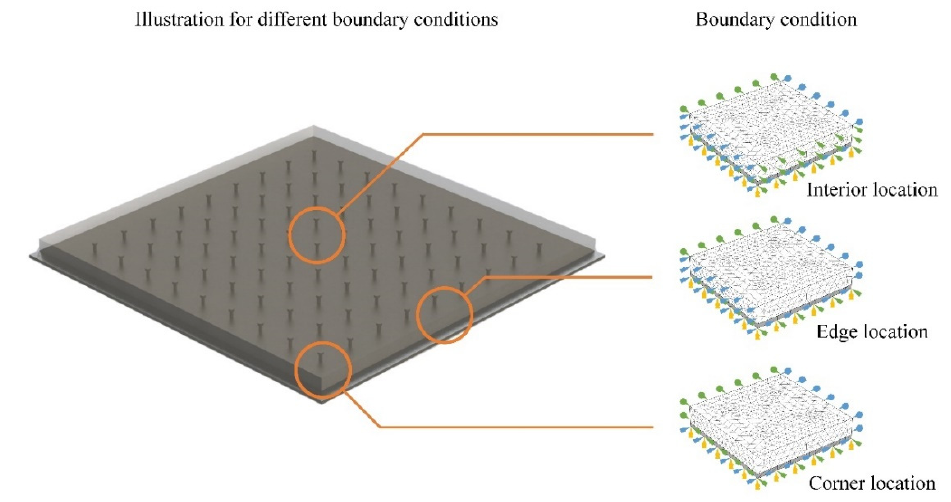
Figure 10. Boundary-condition modification of the FEA model.